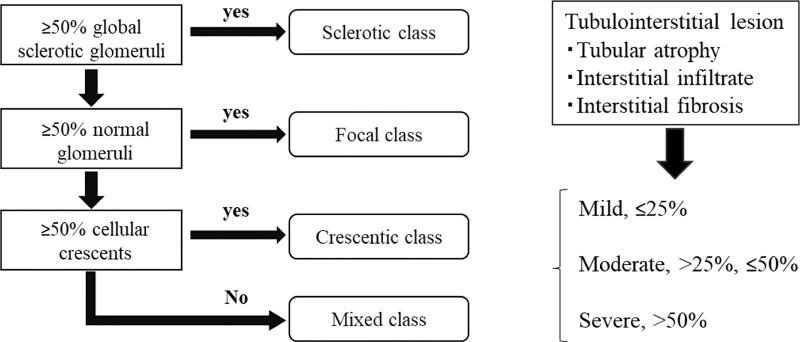
Schematic representation of pathological categorizations based on glomerular lesions and semiquantitative analysis of tubulointerstitial injury in ANCA-associated glomerulonephritis.